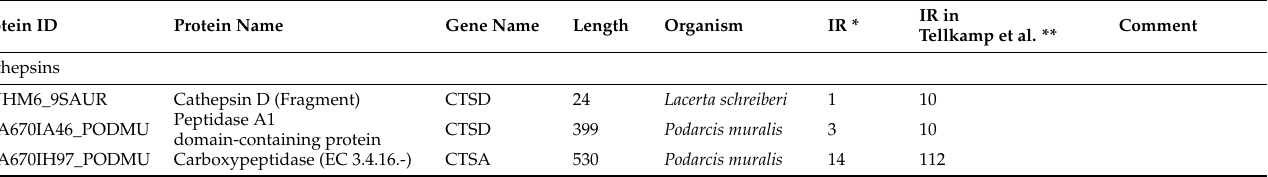
Figure 2. Top left: Density plot of the molecular weight (kDa) for protein groups with a valid iBAQ in at least 10 out of 15 samples (i.e., a total of 667 proteins selected). Heat map showing Pearson correlation coefficients for the 15 samples based on the iBAQ values of the 667 selected proteins. Scale shows color correspondence for the Pearson coefficient values. Table 1. Thirty most abundant proteins (Top30) detected in the femoral gland secretions of sand lizards. Top30 proteins were manually grouped by function with the help of the information available in the UniProt database [34]. IR: Intensity